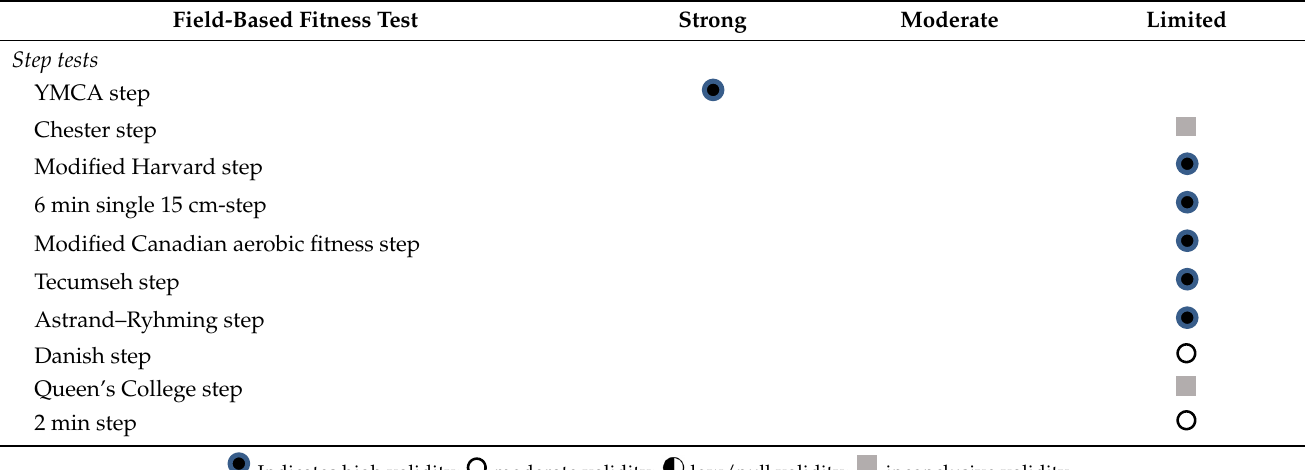
Table 2. Levels of evidence of muscular strength, flexibility and motor fitness Table 1. Levels of evidence of cardiorespiratory fitness tests.